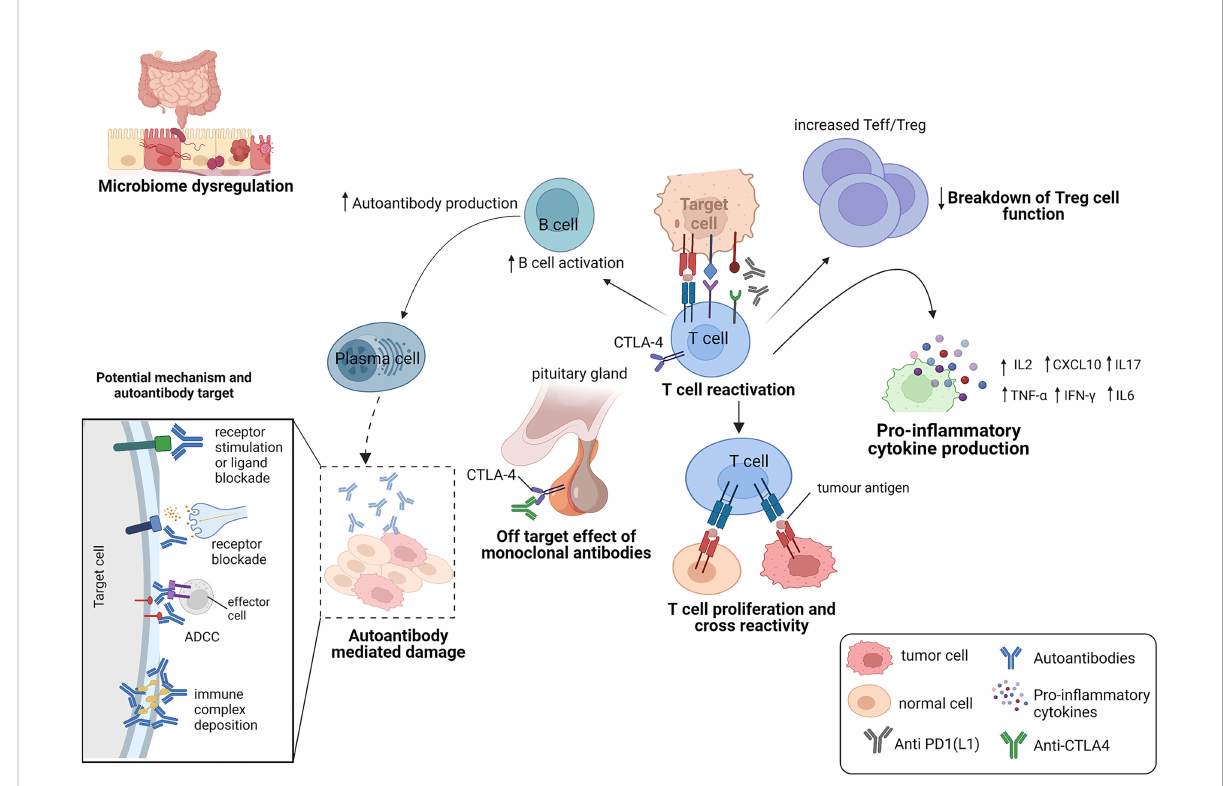
FIGURE 3 Potential mechanisms of immune related adverse